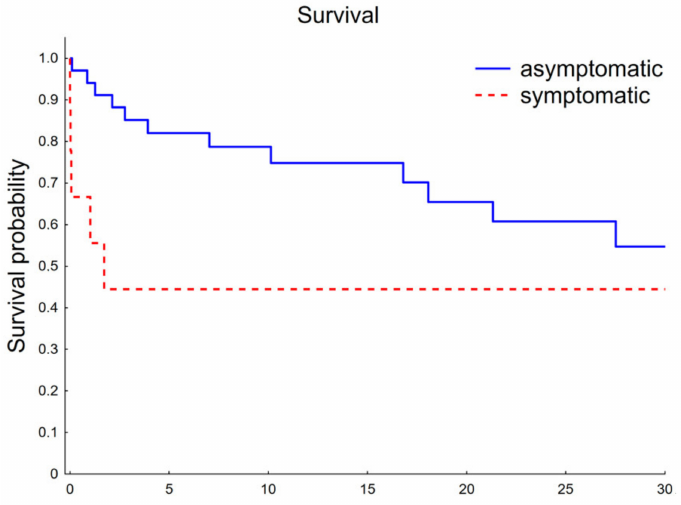
Figure 5. Survival comparison between asymptomatic and symptomatic